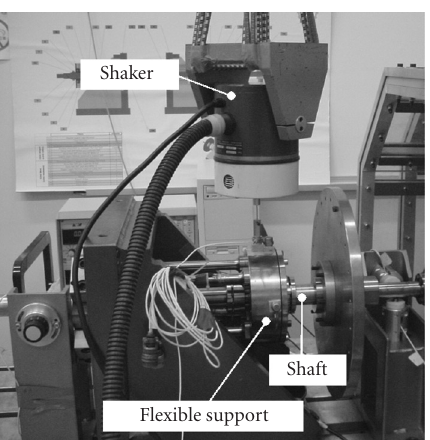
Figure 6: Experimental setup for measuring the Campbell diagram.